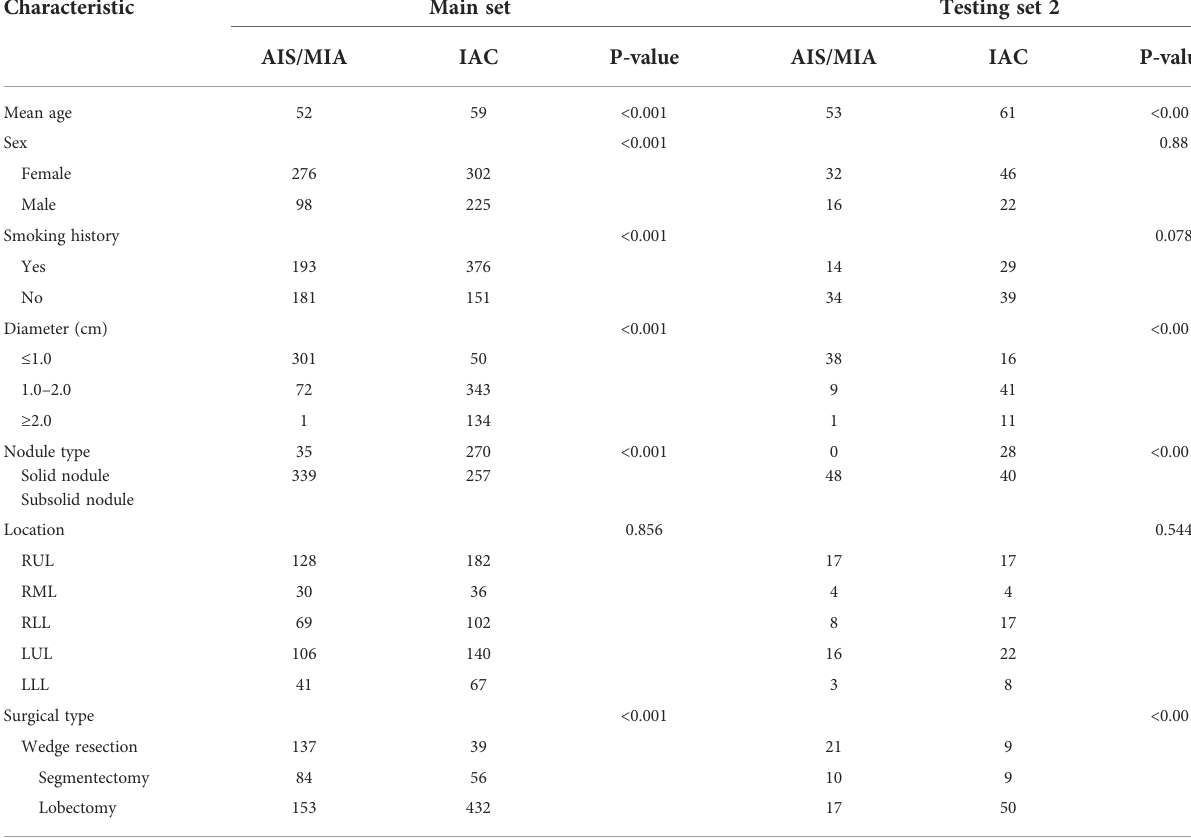
TABLE 1 Clinicopathologic characteristics of the patients in the main set (including the training set and testing set 1) and testing set 2.